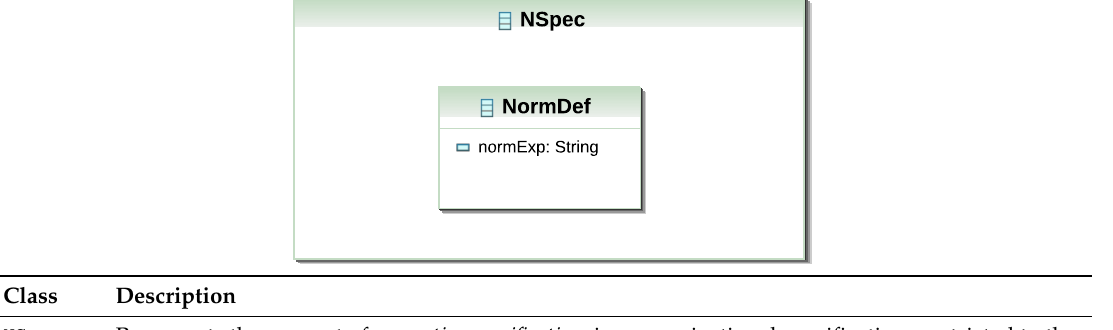
Table 7. Normative specification pattern: Class